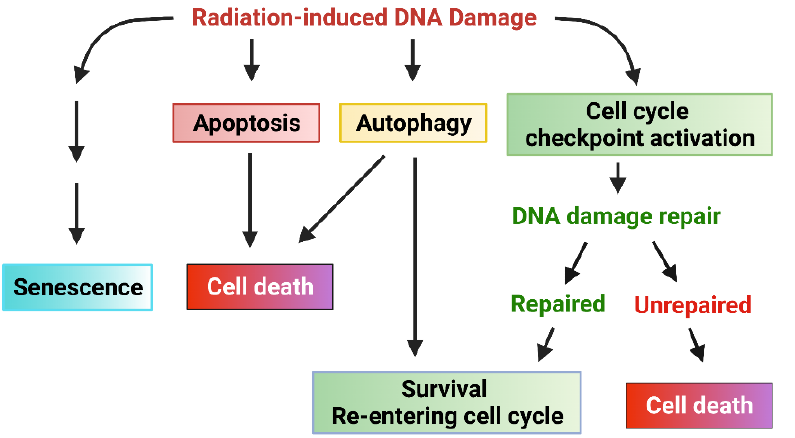
Figure 1. Cellular response to radiation-induced DNA damage. Ionizing radiation (IR) induces DNA damage in cancer cells in the form of either single-strand breaks (SSB) or double-strand breaks (DSB). DNA damage sensed by cells results in various cellular responses: senescence, apoptosis, autophagy, cell cycle arrest, and DNA repair. Signaling pathways that promote cell cycle checkpoint activation/DNA repair and inhibition of apoptosis can protect cancer cells from IR-induced cytotoxicity, promoting survival and the subsequent radiation resistance of cancer cells.